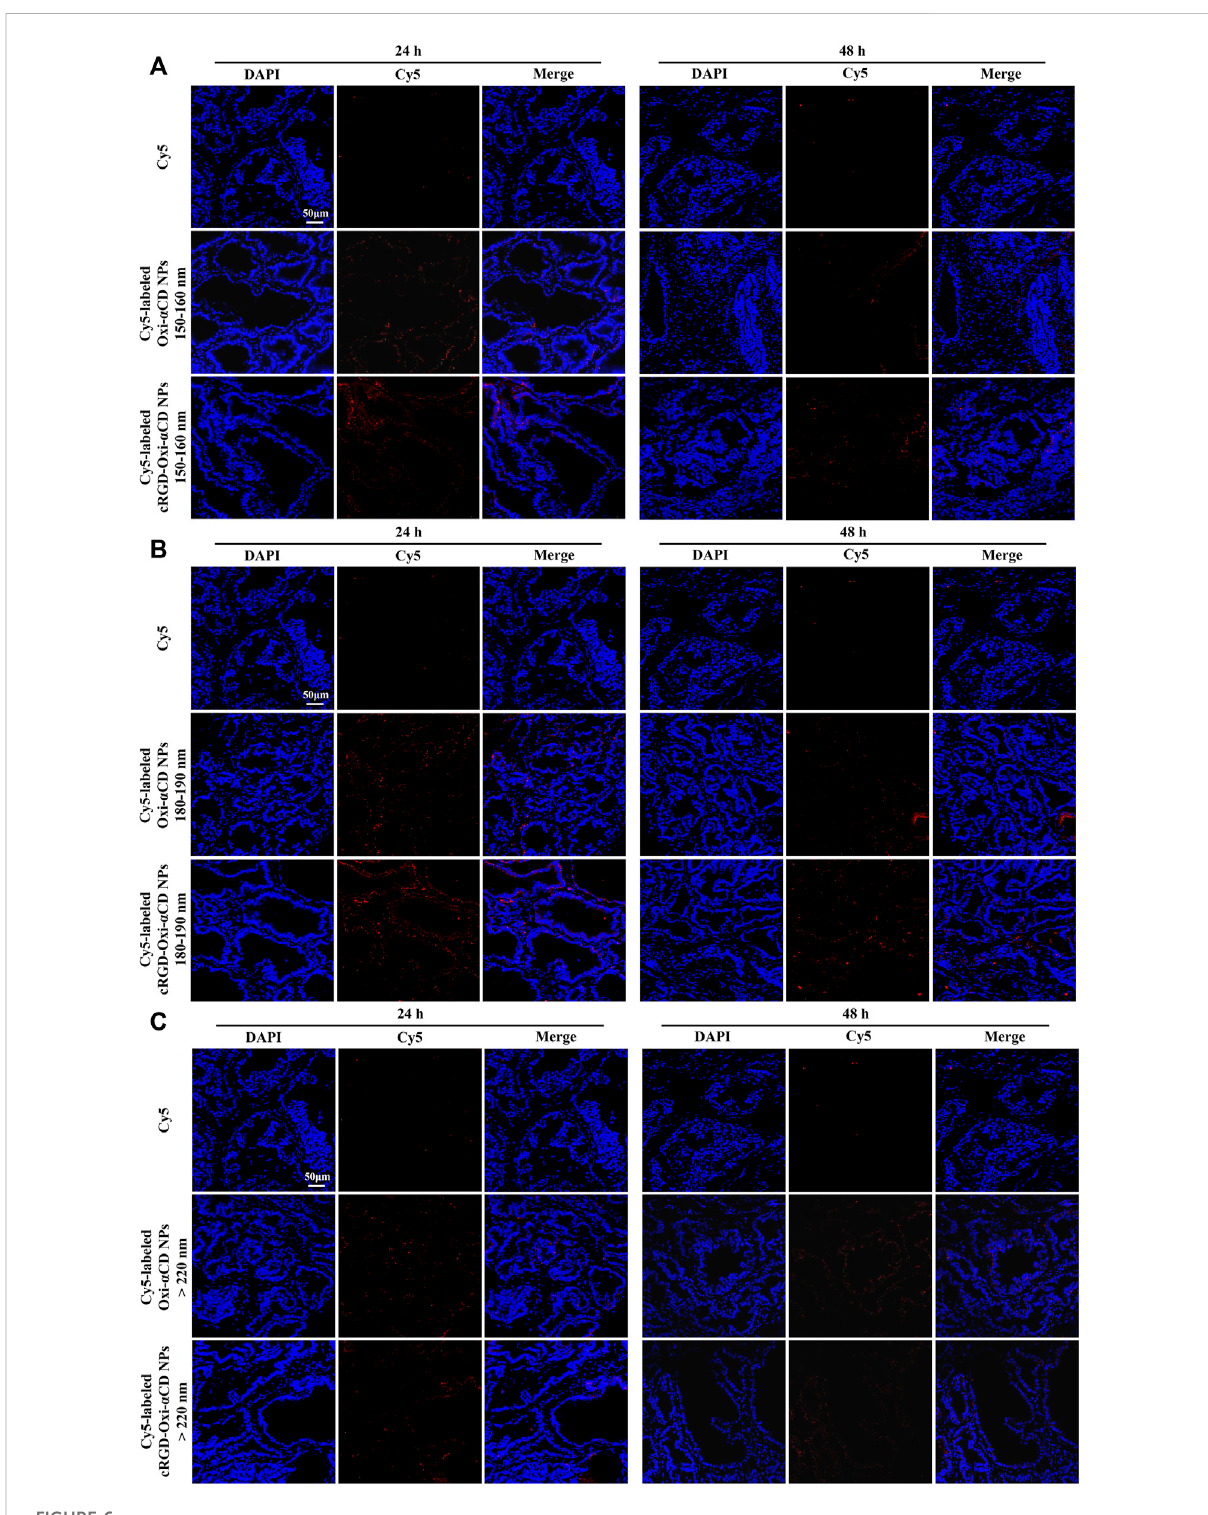
FIGURE 6 CLSM images of prostate tissues treated with Cy5 or Cy5-labeled NPs for 24 and 48 h. Red indicates NPs, and blue indicates DAPI. (A) 150 – 160 nm, (B) 180 – 190 nm and (C) > 220 nm. The scale bar represents 50 μ m.